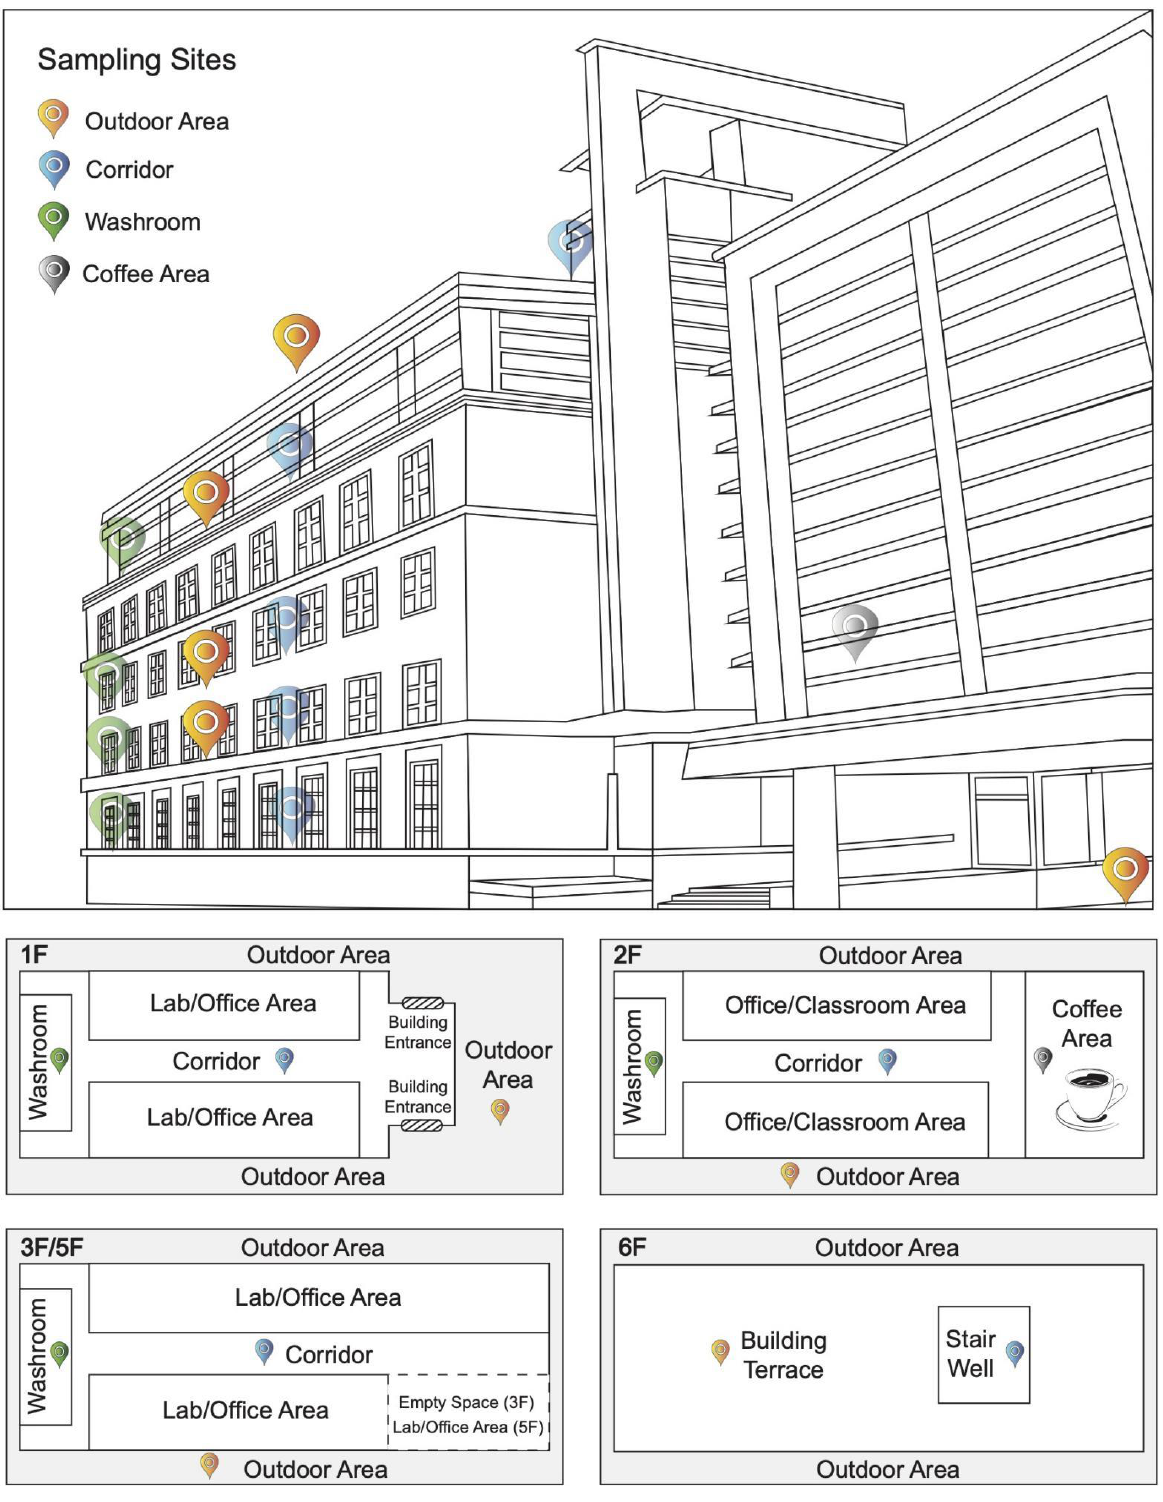
Figure 1. Schematic diagrams of Tianjin University building 24 (front view) and sampling floors (vertical view). Half of the building and floors were displayed, since the layout of the building and each floor are practically symmetrical. The fifteen sampling sites are marked in the diagrams.